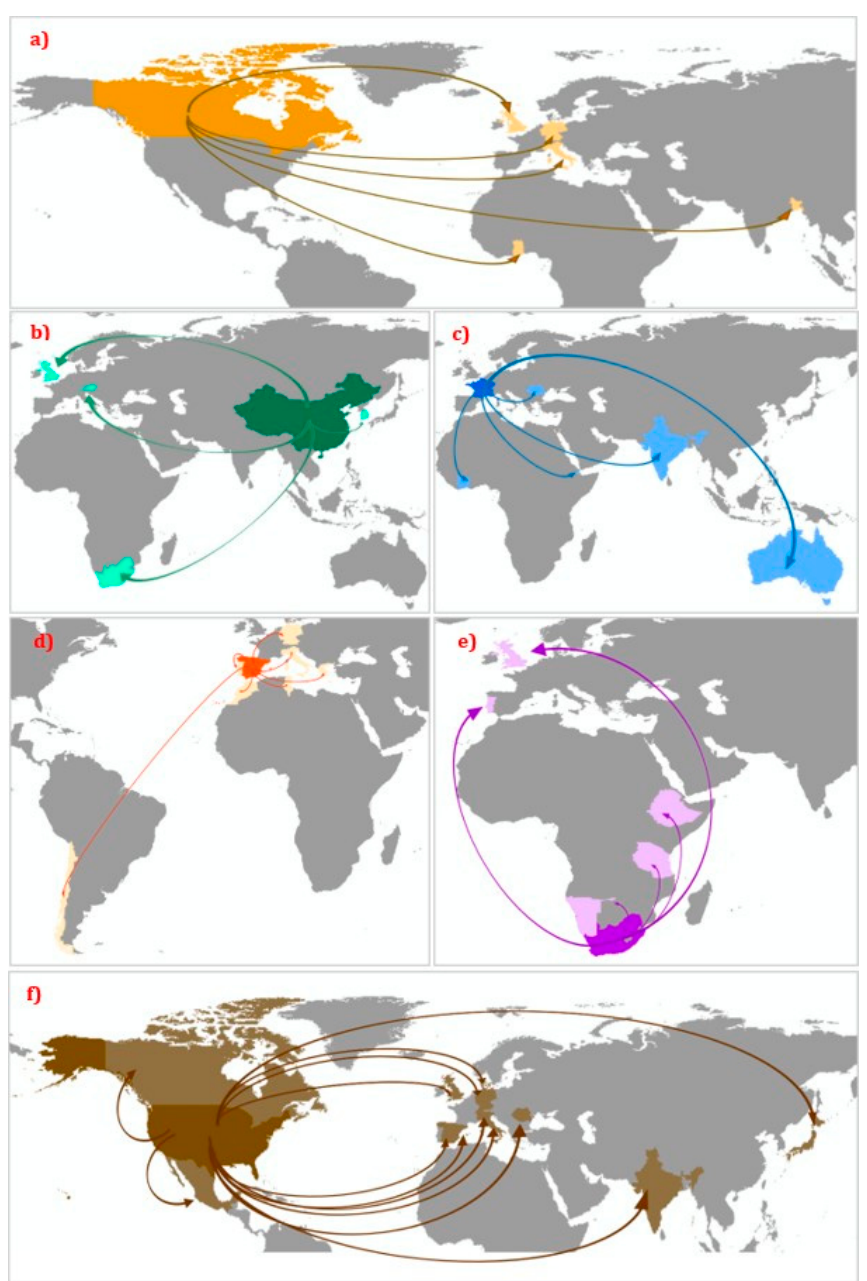
Figure 4. Countries with the highest levels of collaboration between 1980 and 2020. ( a ) Collaborations between Canada and Bangladesh, Germany, Ghana, Italy and the United Kingdom. ( b ) Collaborations between China and Austria, Korea, South Africa and the United Kingdom. ( c ) Collaborations between France and Australia, Cote D’Ivoire, Djibouti, India and Romania. ( d ) Collaborations between Spain and Chile, Germany, Greece, Italy, Morocco, Portugal and Tunisia. ( e ) Collaborations between South Africa and the United States, Ethiopia, Namibia, Portugal, Tanzania and the United Kingdom. ( f ) Collaborations between the United States and Canada, Denmark, Germany, India, Italy, Japan, Mexico, Monaco, Romania, Spain, Switzerland, and the United Kingdom.